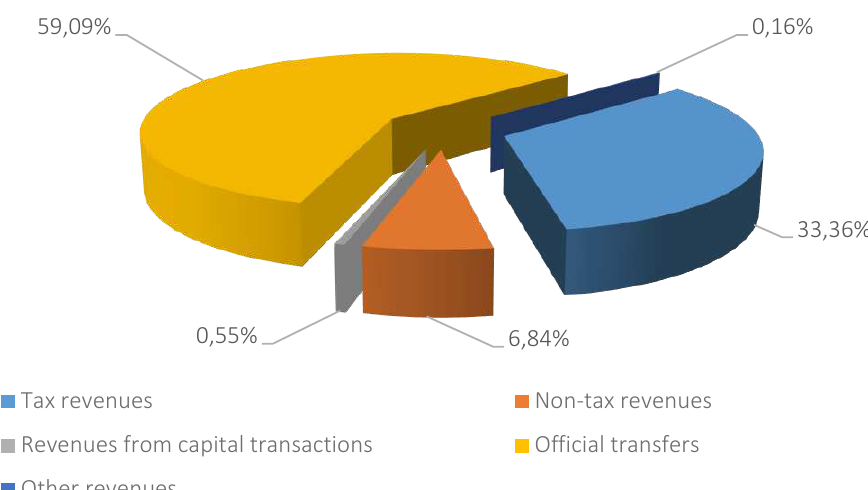
Figure 2. The structure of revenues of local budgets in Ukraine in